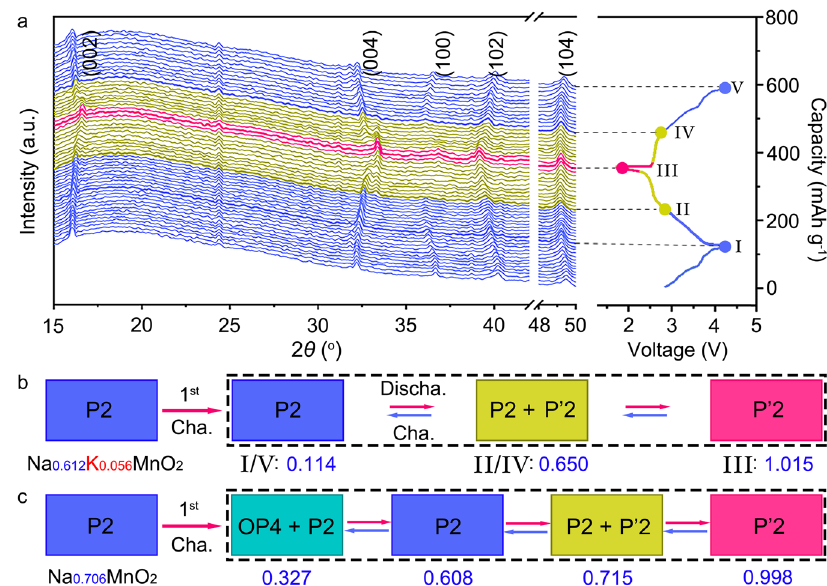
Fig. 3 Structure evolution during charge and discharge. a In situ XRD patterns corresponding to the charge and discharge curves of Na 0.612 K 0.056 MnO 2 . Schematic illustration of phase transitions along with the content change of Na + in Na 0.612 K 0.056 MnO 2 ( b ) and Na 0706 MnO 2 ( c ) in cycles of charge and